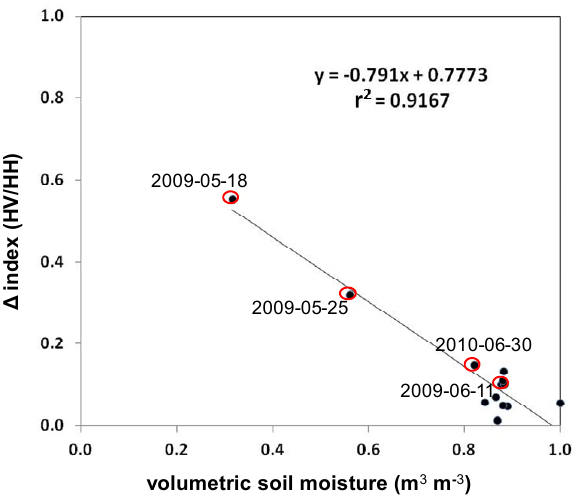
Figure 5. Regression analysis for Δ -Index (multi-polarization and cross-polarization